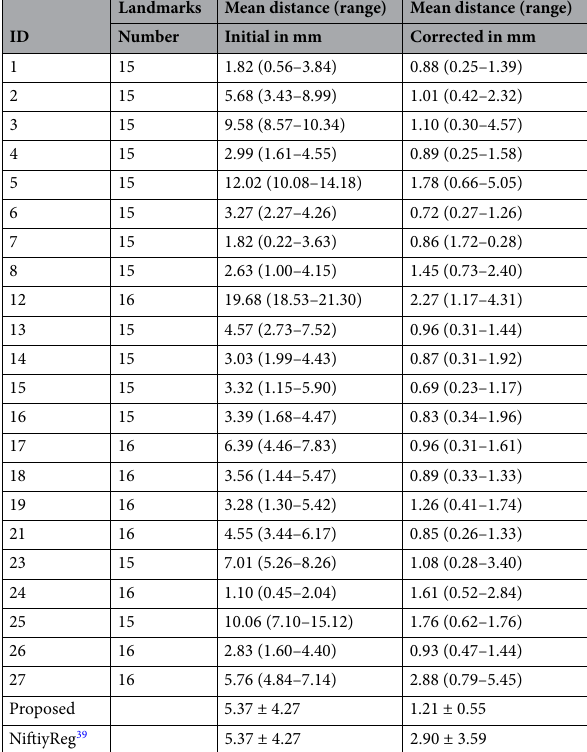
Table 3. Evaluation of the mean distance between landmarks in MRI and ultrasound before and after